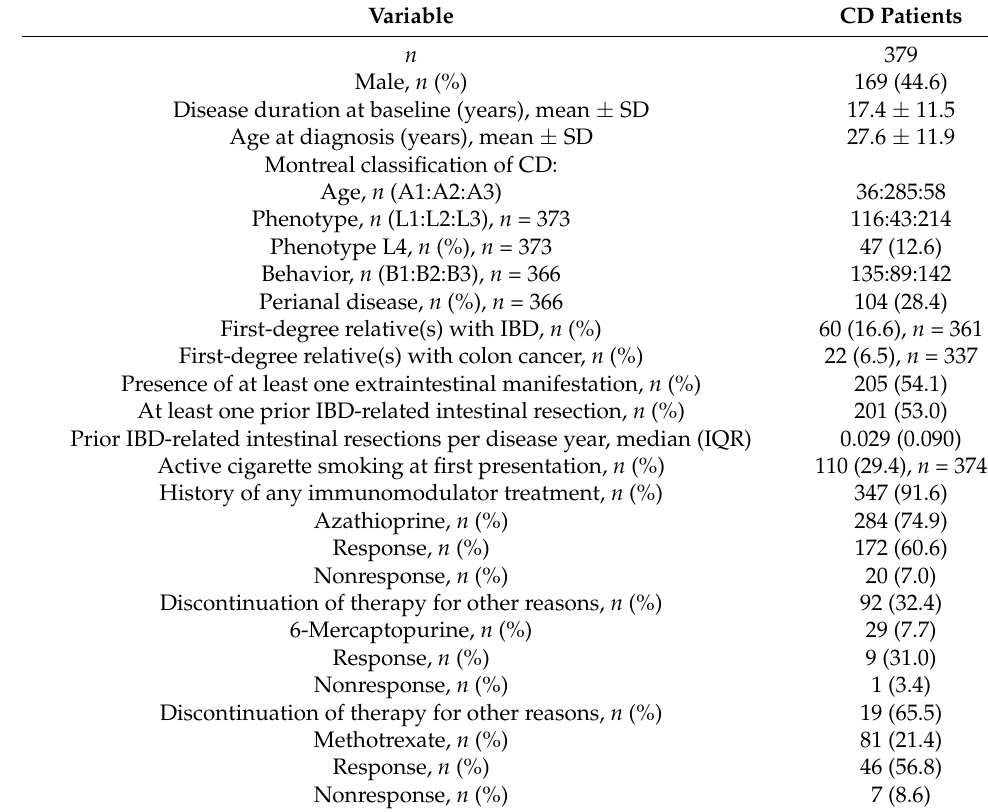
Table 2. Baseline characteristics and therapy outcomes of the included patients ( n = 379).